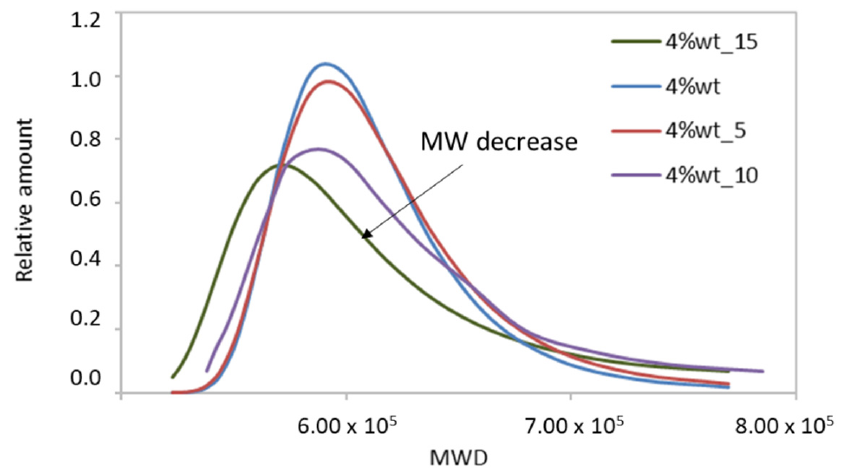
Figure 7. Distribution of molecular weights obtained with RheoWin software for 4% wt samples with different thermo–mechanical